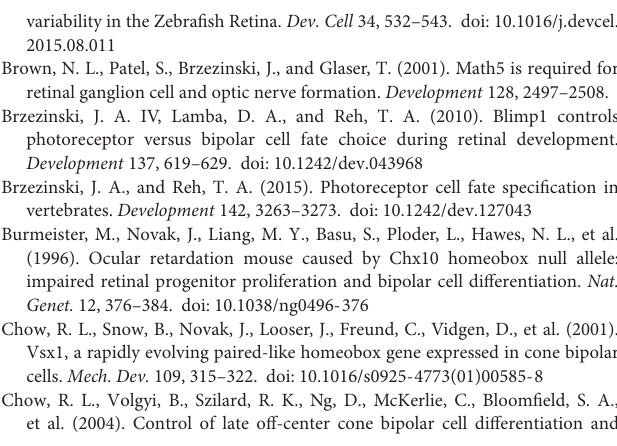
Supplementary Figure 1 | A subset of INL atoh7:GFP -positive cells extend processes below the ganglion cell layer. (A–C) Maximum projections of nine confocal images of Tg[atoh7:GFP]rw021 retinal sections immunolabeled for GFP (A,C,D) , HuC/D (B–D) , and PCNA (D) at 72 hLT. Yellow arrows indicate atoh7:GFP-positive soma located in the INL that extend processes below HuC/D-positive ganglion cells (arrowhead). Supplementary Figure 2 | Neurite extension into the IPL at 2 drec. (A–L) Confocal images from an EdU-injected (B–D,F–H,J–L) Tg[ptf1a:GFP]jh1 retinal wholemount immunolabeled for GFP (A,C–E,G–I,K,L) and DAPI (D,H,L) . (A–D) Single z-plane confocal images. (E–L) 3D XY (E–H) and XZ Maximum projection